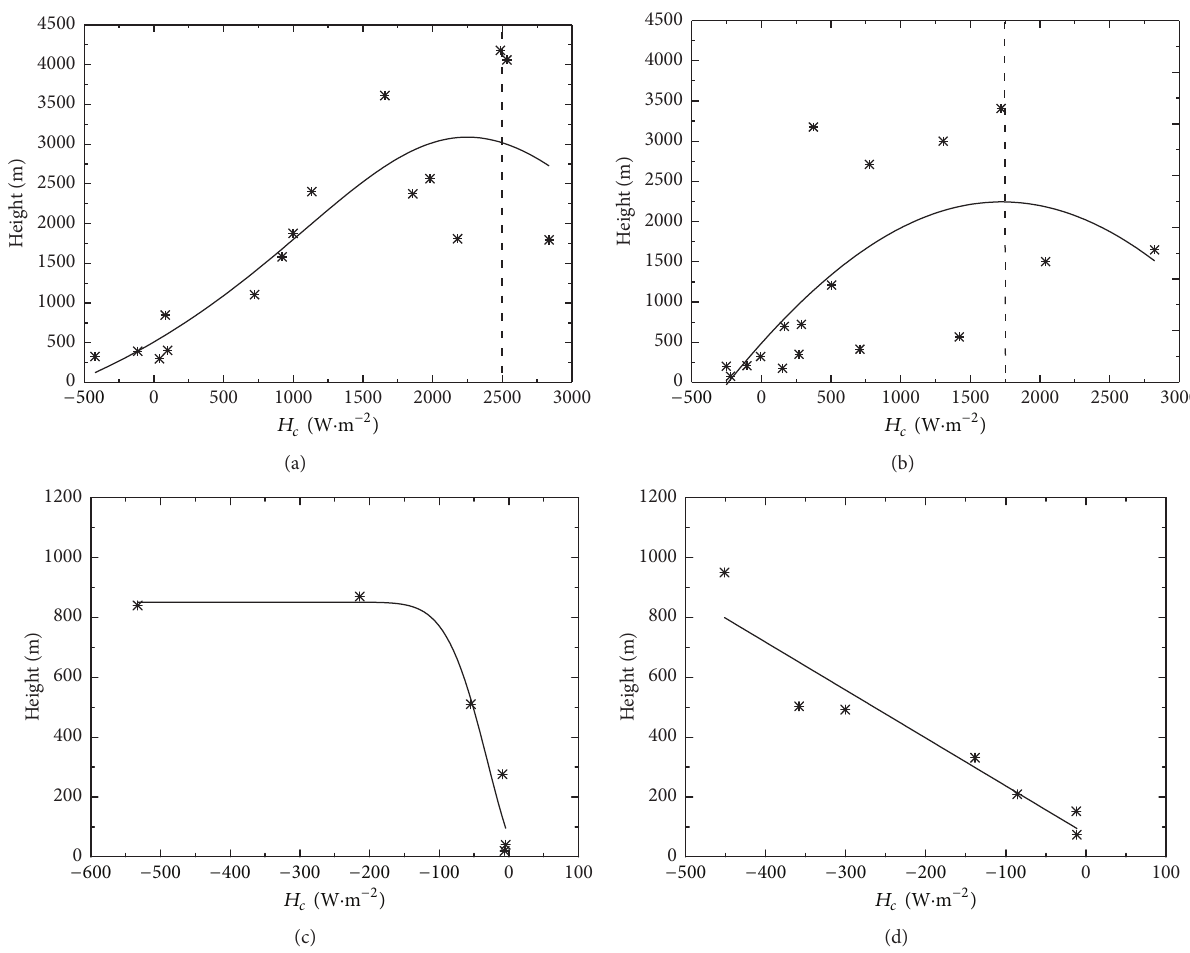
Figure 7: The relationship between (a) CBL and 𝐻 𝑐 in midsummer in 2012; (b) CBL and 𝐻 𝑐 in late summer in 2009; (c) SBL and 𝐻 𝑐 in midsummer in 2012; (d) SBL and 𝐻 𝑐 in late summer in 2009.